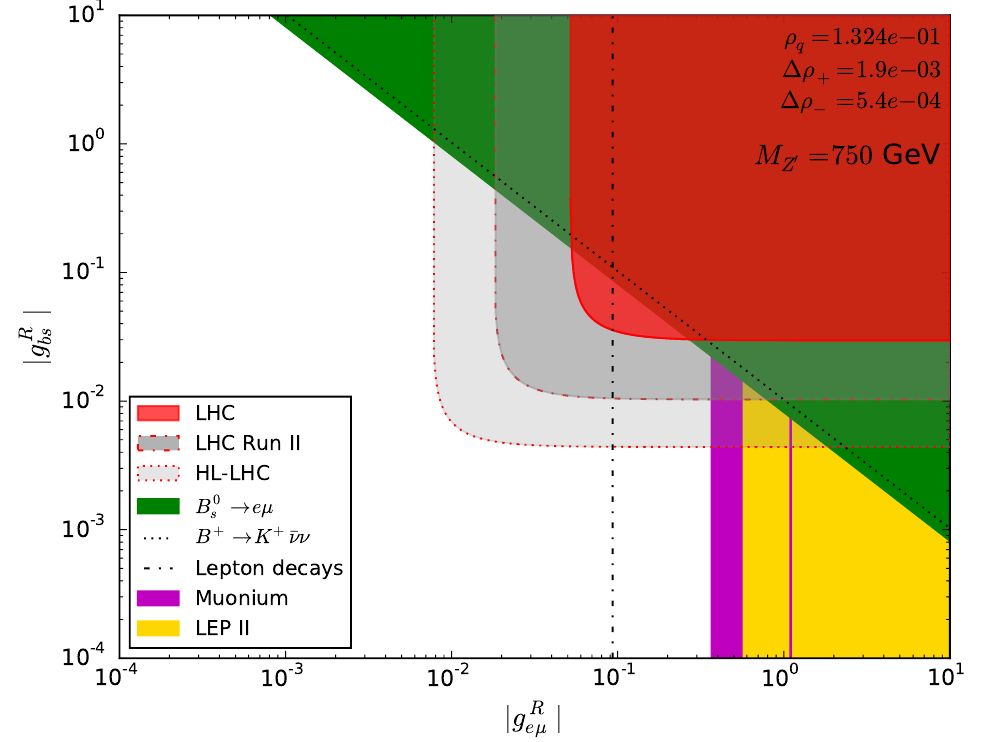
Figure 1 . The (cid:13)avor-violating couplings g R and g R for a Z 0 boson of M Z 0 = 750 GeV and a e(cid:22) bs coupling ratio of (cid:26) q = g L =g R = 0 : 1324 (for an explanation of (cid:1) (cid:26) see section 3.1.1). The red area bs bs p indicates the limit from the ATLAS analysis of the process pp ! e(cid:22) at s = 8 TeV. The red dash-dotted and dashed lines are projections to the LHC Run II and HL-LHC. The green area is the limit coming from the meson decay B 0 ! e(cid:22) . The gold and magenta areas are purely leptonic s limits coming from LEP and muonium oscillation constraints. Finally, the black dotted line is the exclusion limit from B + ! K + (cid:22) (cid:23)(cid:23) and the black dash-dotted line the limit from lepton